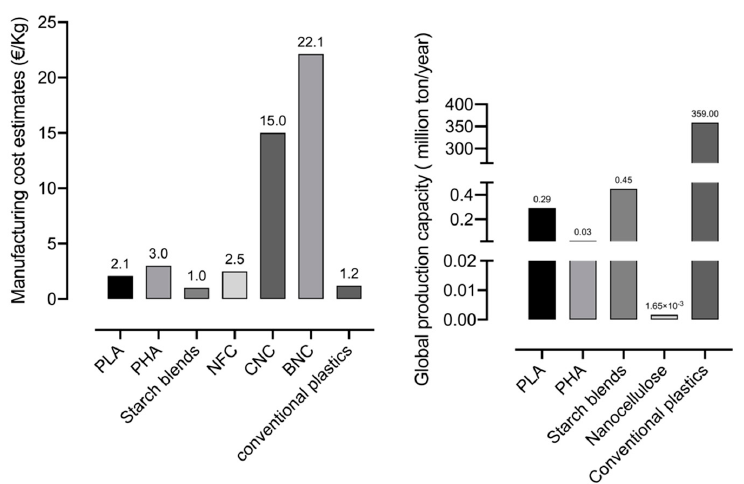
Figure 4. Global production capacity of bio-based and biodegradable materials; manufacturing cost estimates of bio-based materials, nanocelluloses (NFC, CNC and BNC) and conventional plastics (values adapted from [172–180]).